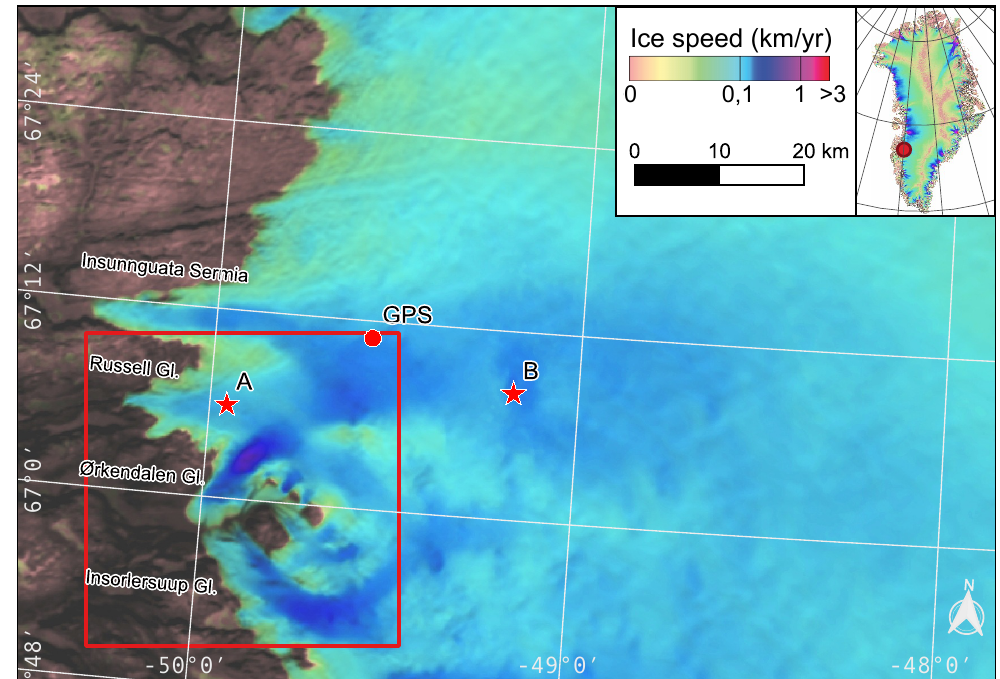
Figure 1. Mean ice velocity in Russell area, from [19]. Red stars indicate the locations for the points A and B mentioned in Sections 2.3 and 4.2 and Figures 4, 9 and 12; red circle indicates the GPS location mentioned in Sections 2.4 and 4.1 and Figures 5, 8, and 12. The red square indicates the location of maps in Figures 10 and